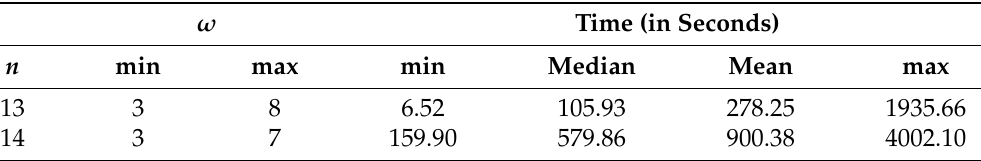
Figure 3. Average execution time in seconds and percentage of time reduction of the ME-RCW algorithm for the profiles of rankings for which the Condorcet winner does not exist. Results are presented for different numbers of alternatives. Table 3. Execution time for profiles of rankings of 13 and 14 alternatives for which the Condorcet winner does not